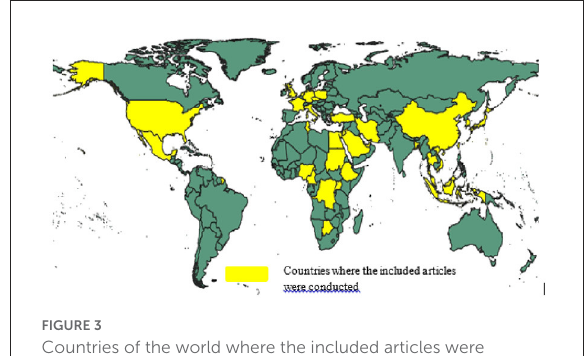
FIGURE3 Countries of the world where the included articles were conducted.